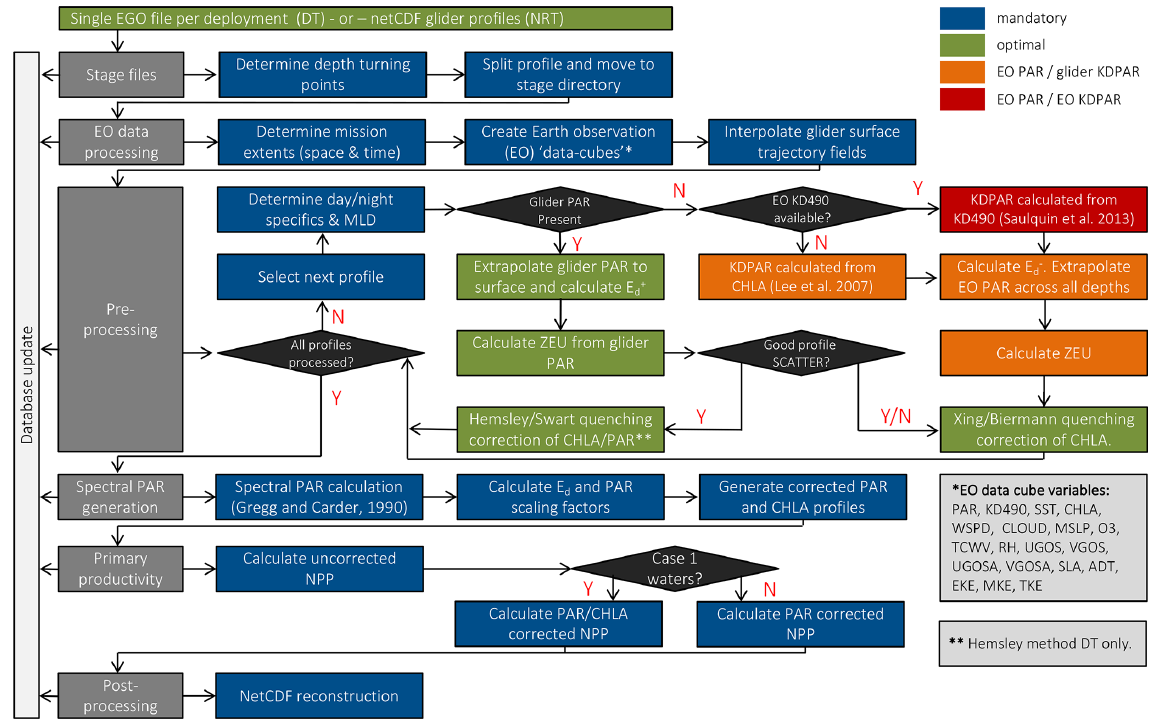
Figure 2. Schematic overview of the glider-based primary production processing chain. Blue boxes indicate mandatory steps; green, orange, and red boxes indicate processing options in order of decreasing preference. The light-grey inset box describes the Earth observation variables that are interpolated onto a glider’s